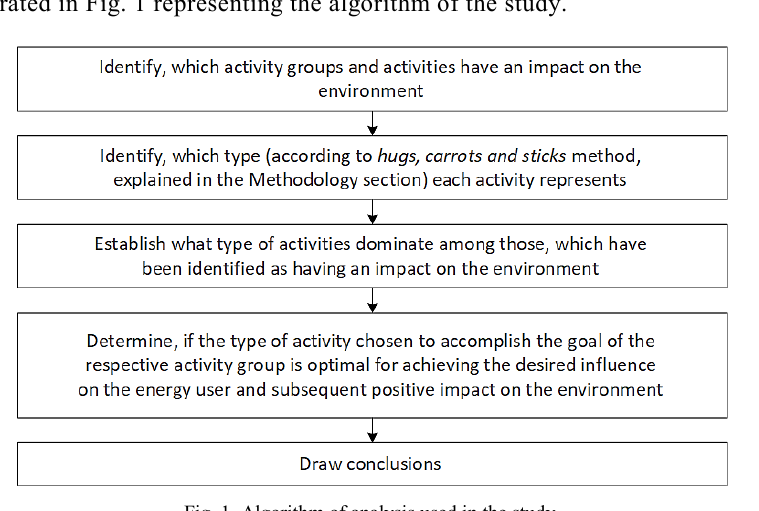
Fig. 1. Algorithm of analysis used in the